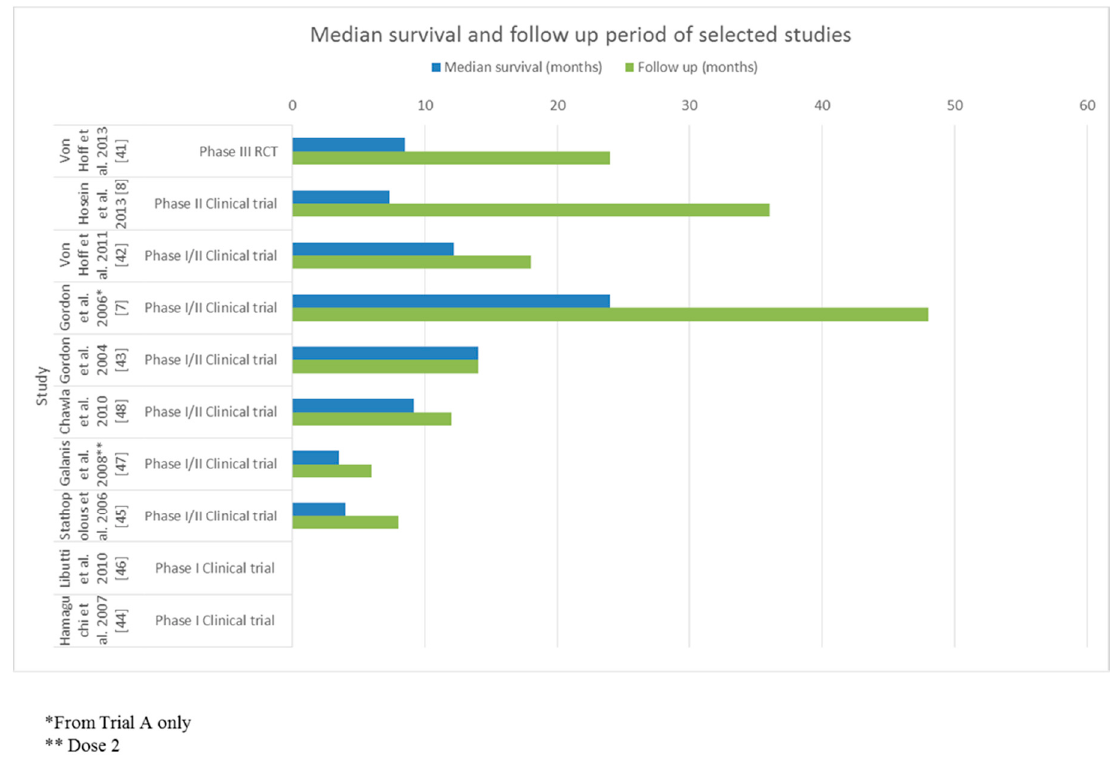
Figure 2. Median survivals and follow up period of selected studies. Abbreviations; RCT = randomised controlled clinical trial.